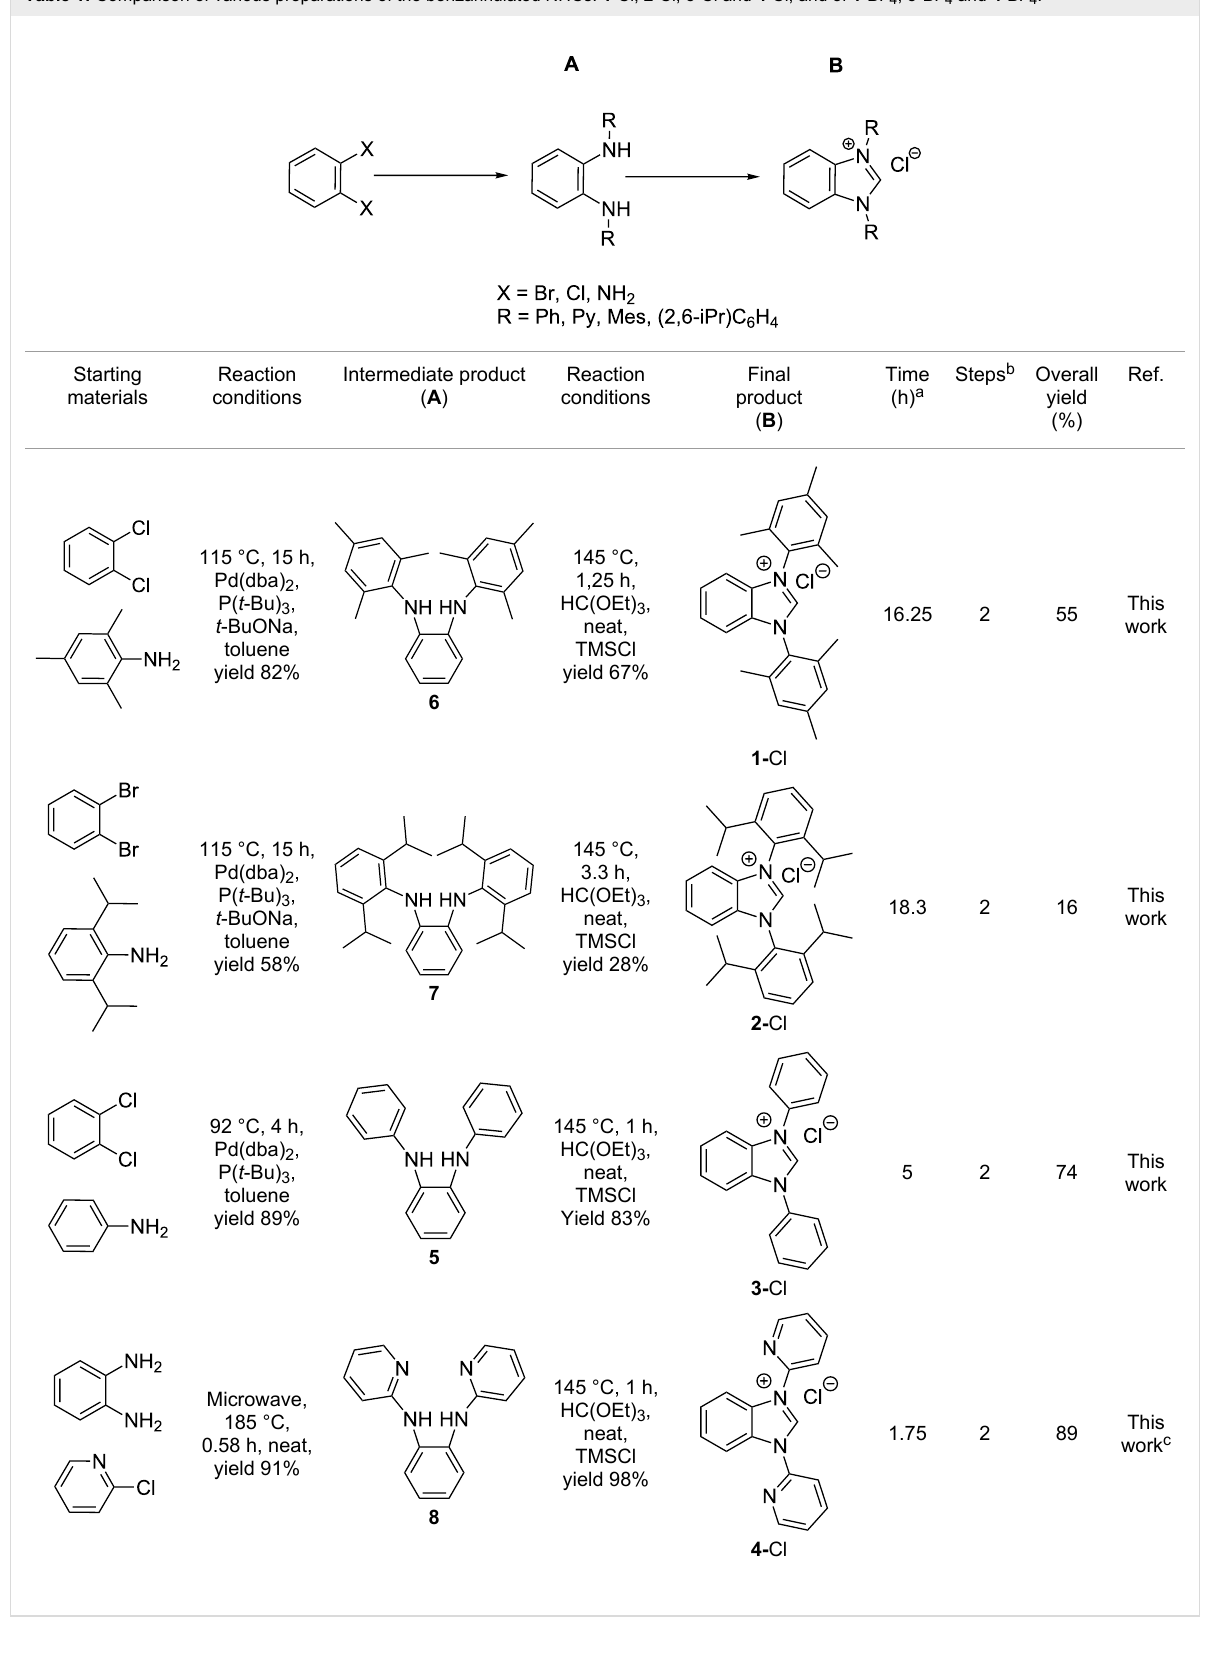
Table 1: Comparison of various preparations of the benzannulated NHCs: 1 -Cl, 2 -Cl, 3 -Cl and 4 -Cl, and of 1 -BF 4 , 3 -BF 4 and 4 -BF 4 .